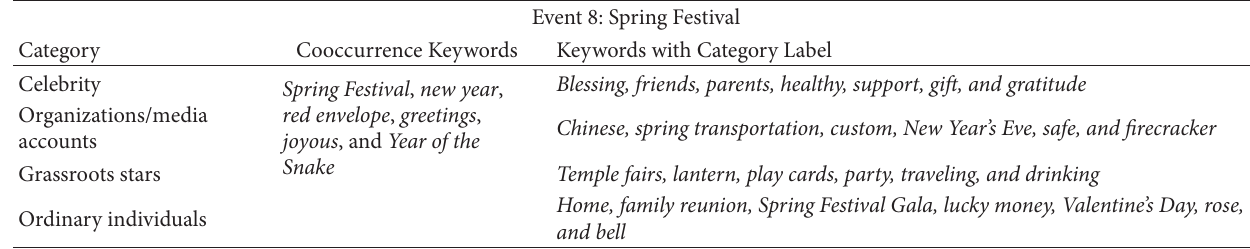
Table 12: Keywords distribution on the event of “Spring Festival.” Event 8: Spring